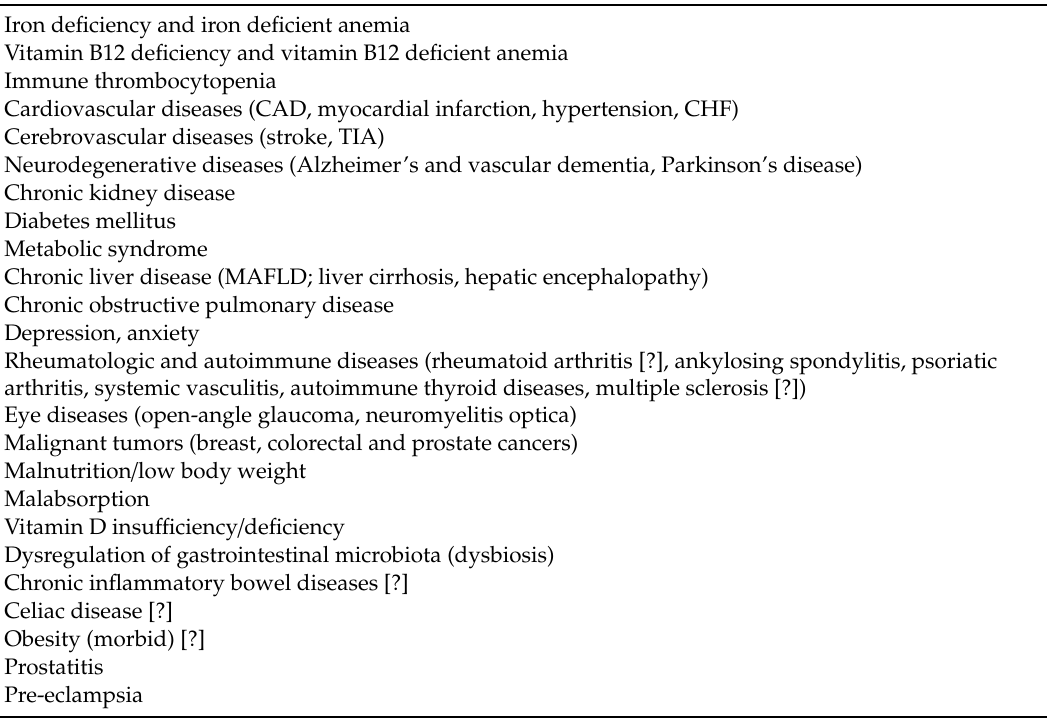
HPI-related chronic extra-gastroduodenal diseases and disorders linked to osteoporotic